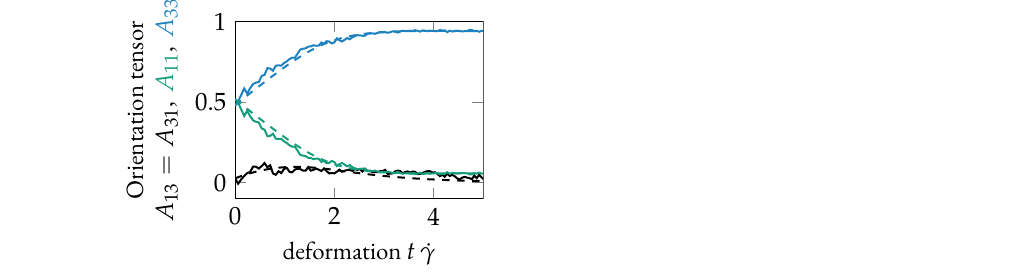
Figure 5. Exemplary Folger Tucker (FT) curves (dashed lines) being fitted to the simulation curves (solid lines).